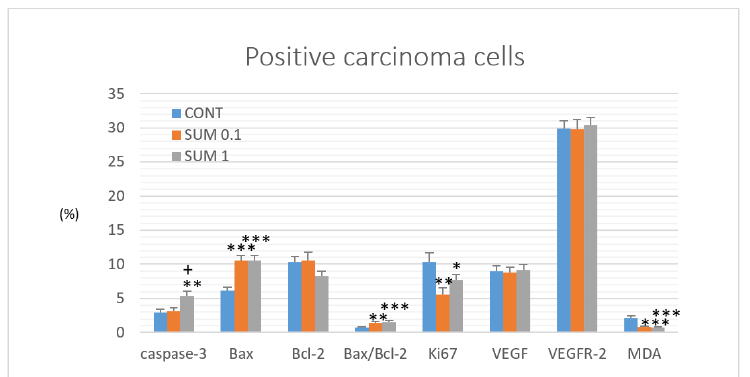
Figure 4. Immunohistochemical evaluation of cleaved caspase-3 (cytoplasmic), Bax, Bcl-2, Ki67, VEGFA, VEGFR-2, and MDA expression in rat mammary carcinoma cells after the administration